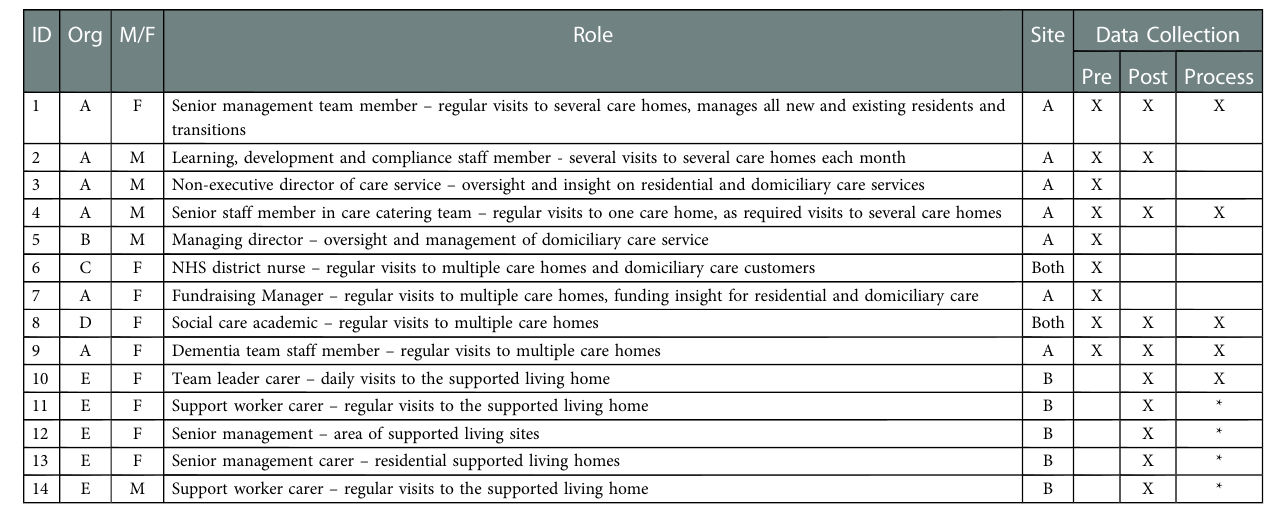
TABLE 1 Stakeholder participants for data